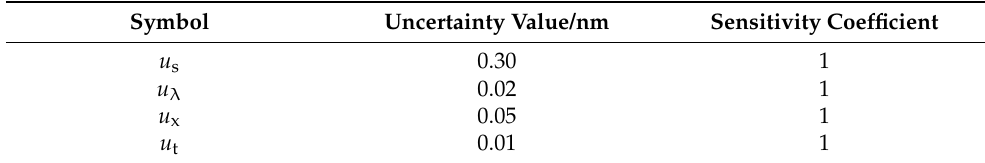
Table 2. Summary of the standard uncertainty components of the grating.